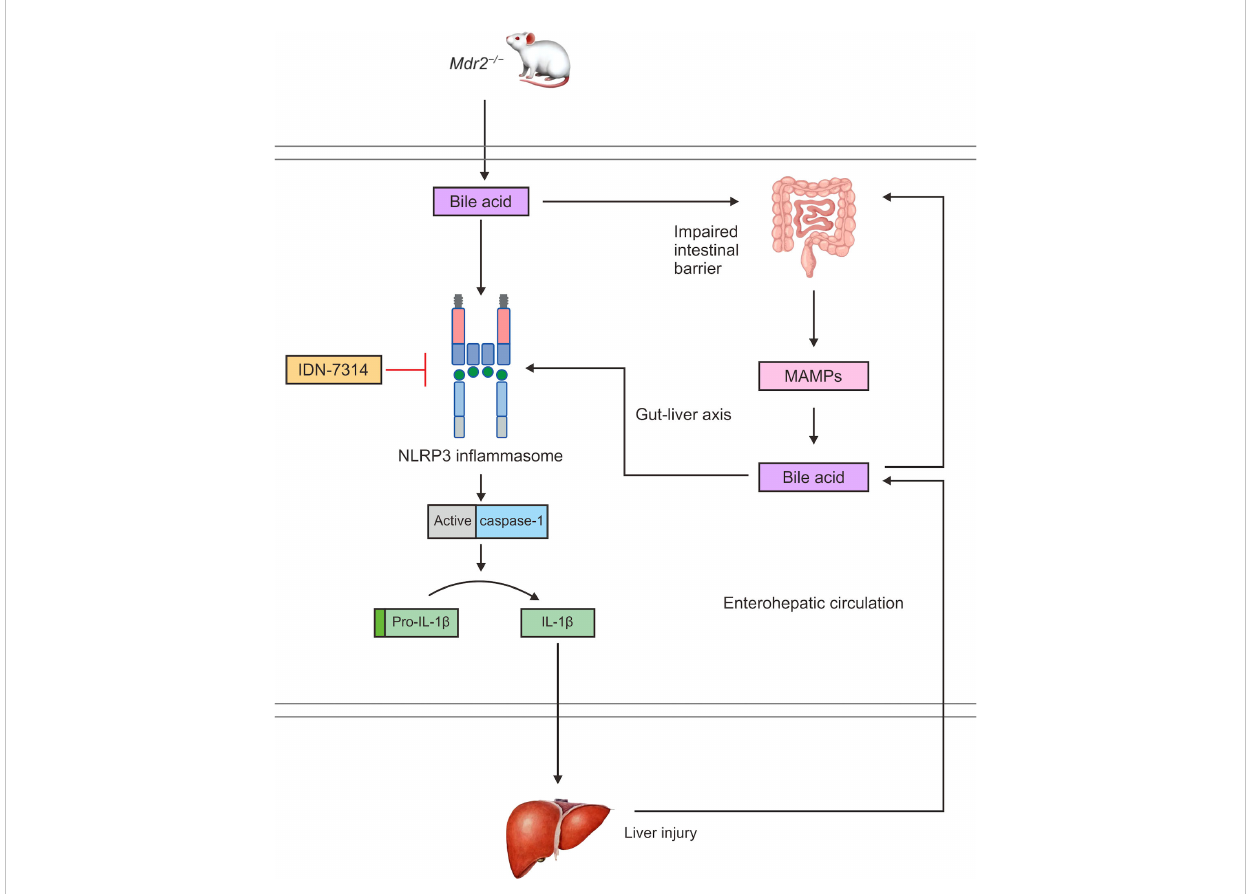
FIGURE 4 In Mdr2 − / − mice, bile acids can activate the NLRP3 in fl ammasome and caspase-1 to cleave pro-IL-1 b to IL-1 b , promoting an in fl ammatory response and liver injury. Bile acids also damage the intestinal mucosal barrier and increase intestinal permeability, which can cause MAMPs to enter the interhepatic circulation through the enterohepatic axis, increasing the exposure of the liver to endotoxins. Toxic bile acids further activate NLRP3 in fl ammasome assembly and promote the maturation and secretion of IL-1 b , thereby expanding the in fl ammatory response and aggravating liver injury. In turn, the liver can affect intestinal homeostasis through the interhepatic circulation of bile